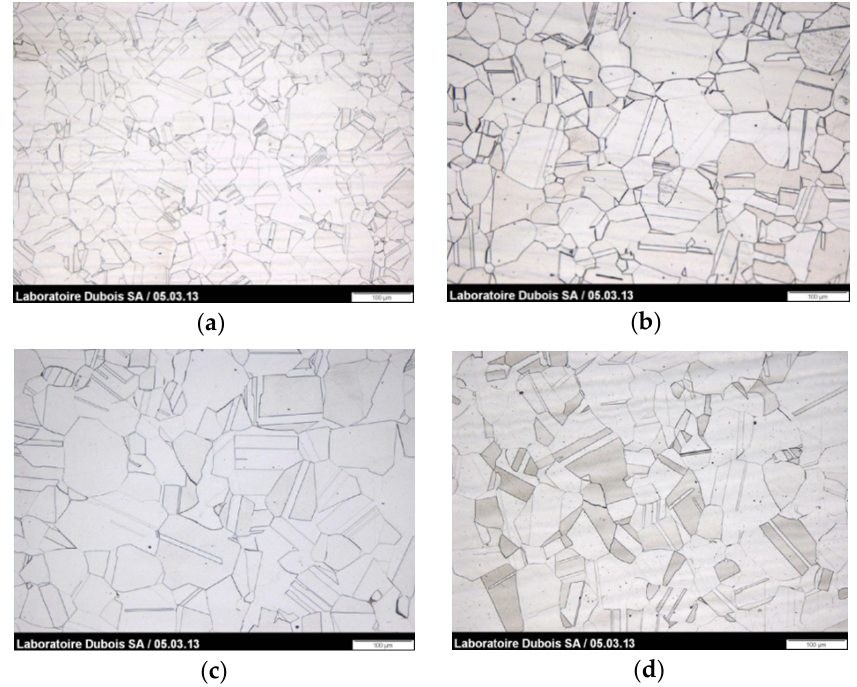
Figure 4. Metallographic structures, performed by optical microscopy, for # 1, # 5, # 7, and # 8 steels. ( a ) #1 317LMN: Supplier 2; ( b ) #8 316L: Supplier 1; ( c ) #5 317LMN: Supplier 1; ( d ) #7 317LMN: Supplier 1.